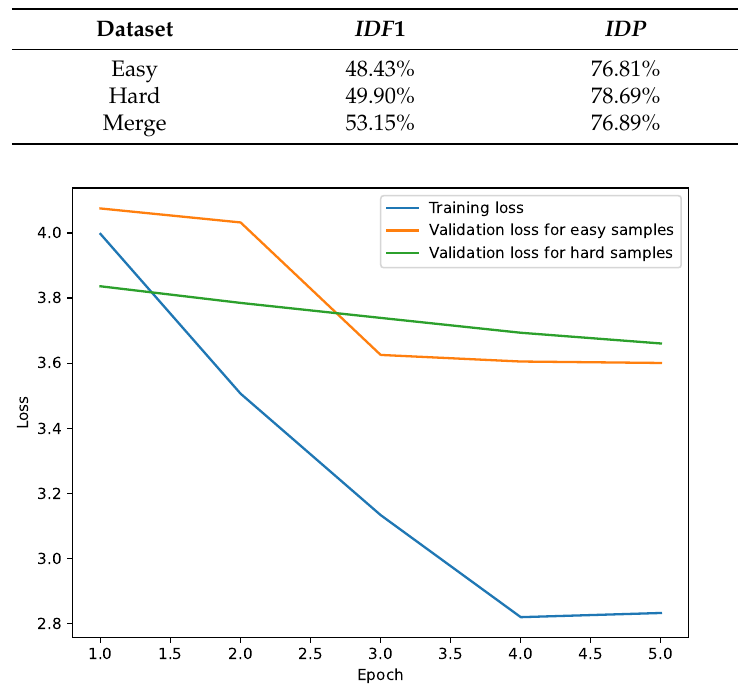
Figure 7. Curves of training loss and validation loss on easy and hard